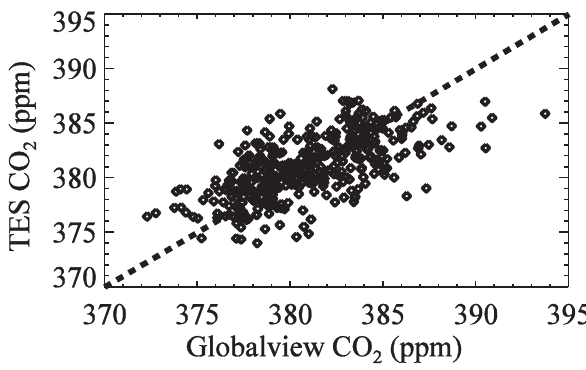
Fig. 13. TES versus GLOBALVIEW data for TES observations Figure 13 within 550km of GLOBALVIEW sites. The agreement is signifi- cant given that TES starts with a uniform 380ppm prior and initial guess.